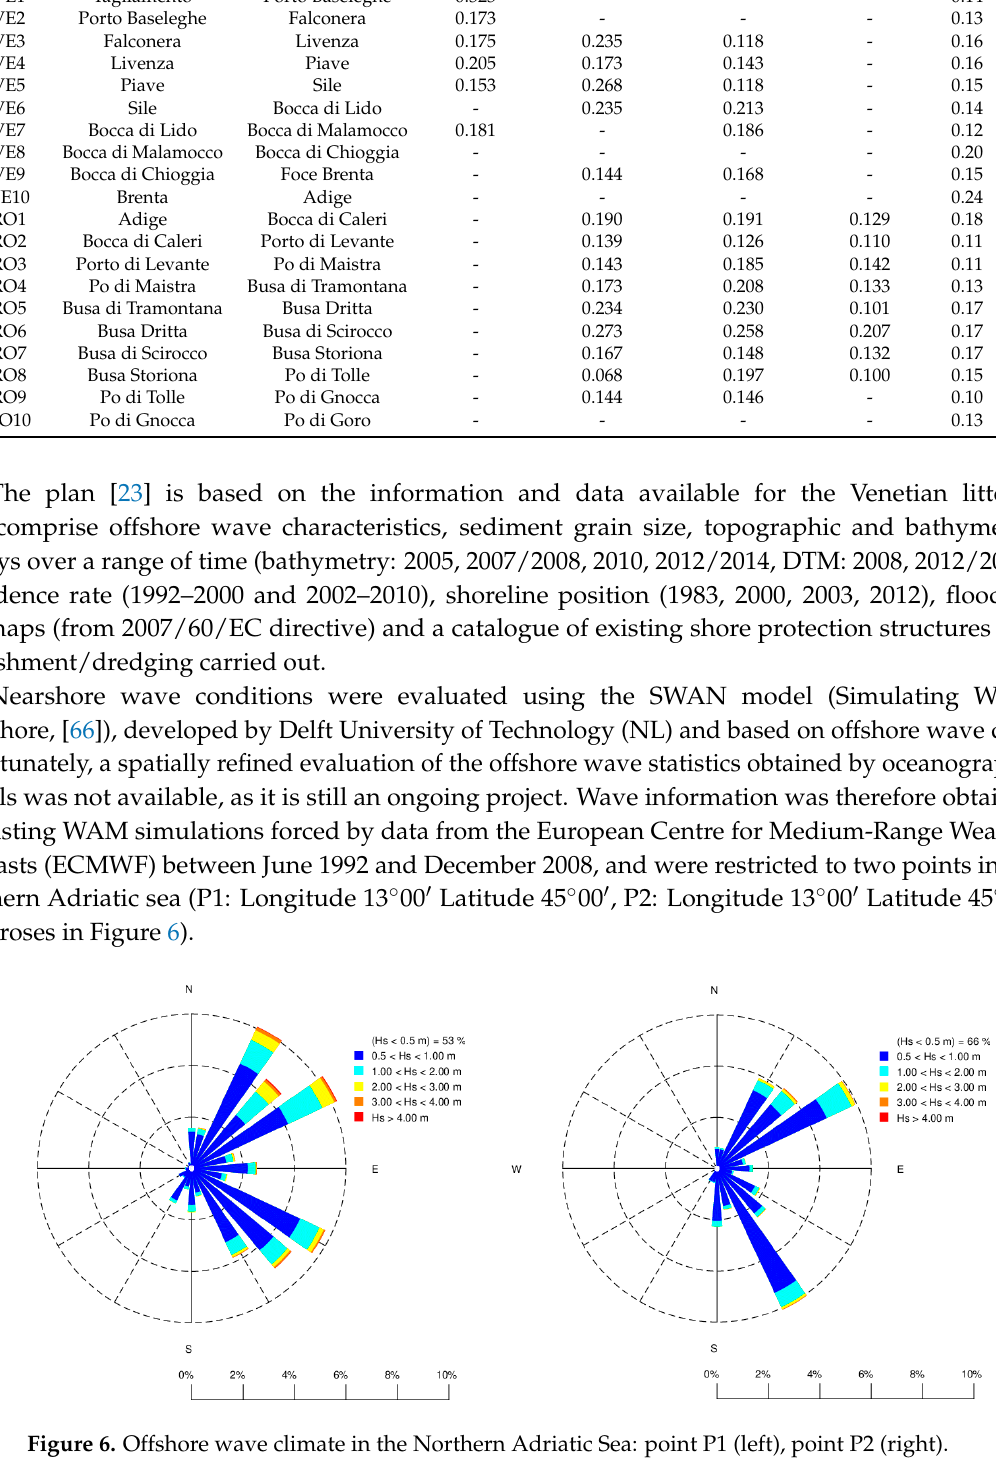
Table 2. Littoral cell boundary, sediment diameter (d 50 , mm) sampled at different depths and evaluated with the Dean rule (d EQ , mm).